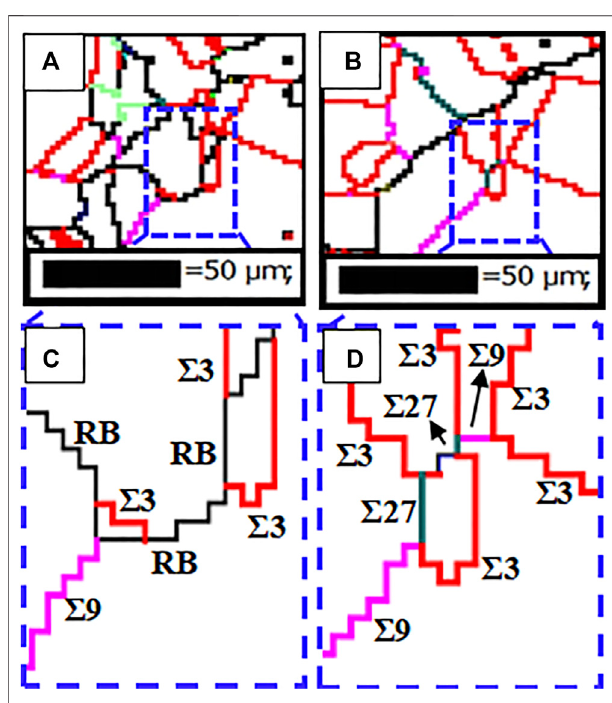
FIGURE 5 | The OIM map of the same region in the GBE-treated specimen annealed for (A) 45 min and (B) 90 min; (C) local enlarged drawing of (A) ; (D) local enlarged drawing of (B)